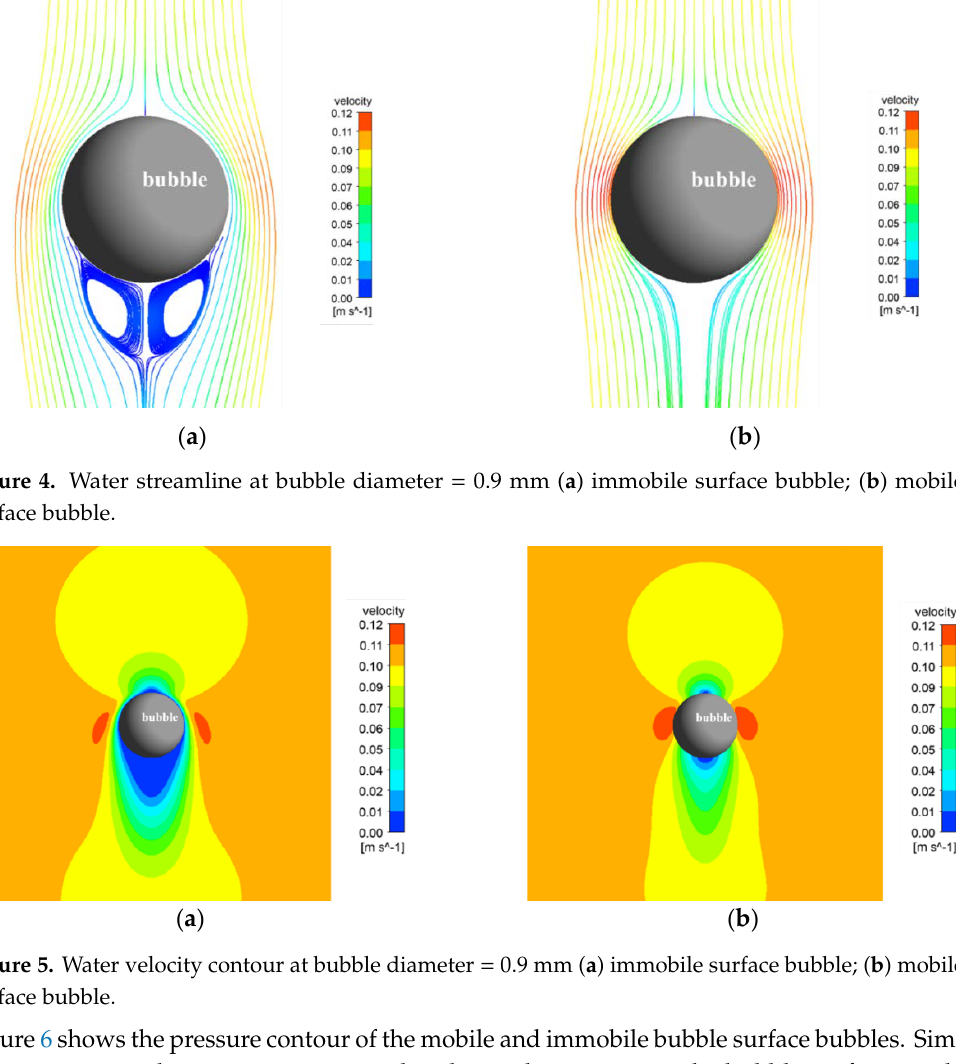
Figure 6. Water pressure contour at bubble diameter = 0.9 mm. ( a ) immobile surface bubble; ( b ) mobile surface bubble).